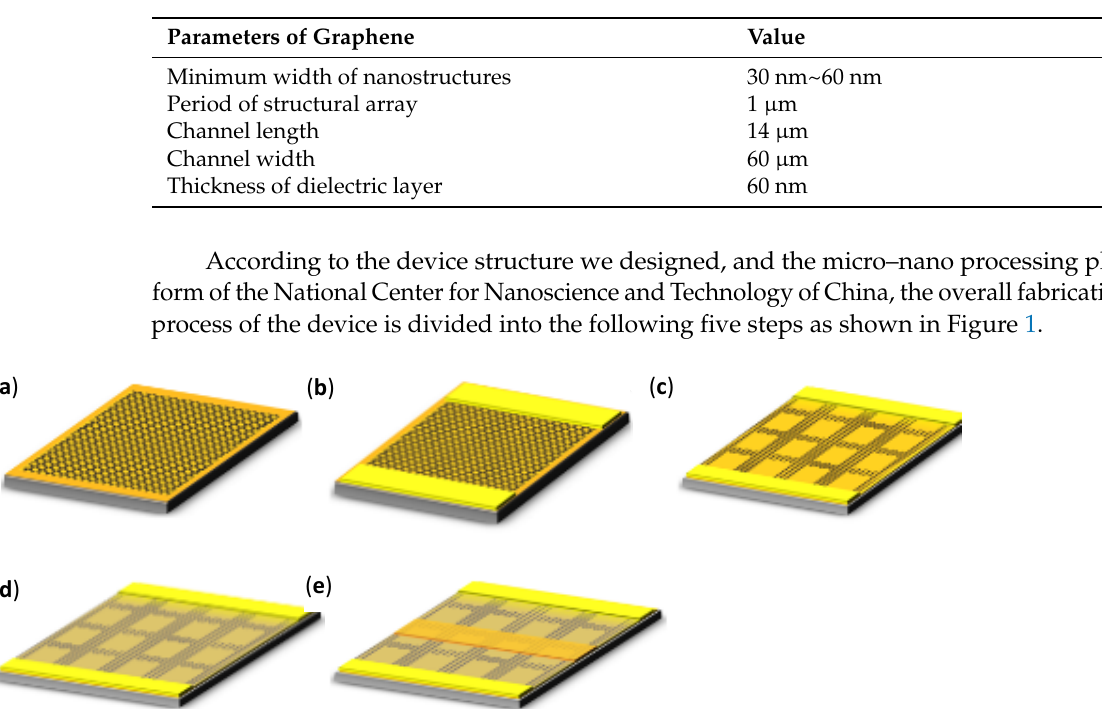
Table 1. Parameters of the graphene FET terahertz detector.